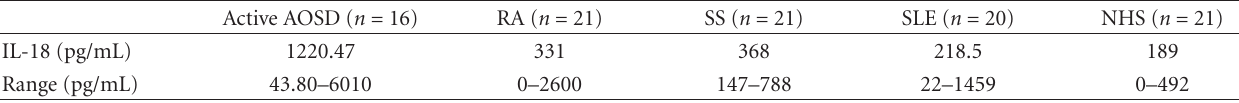
Table 1: IL-18 serum levels in patients with Adult Onset Still’s Disease (AOSD), Rheumatoid Arthritis (RA), Sjogren’s Syndrome (SS), Systemic Lupus Erythematosus (SLE), and in normal human sera